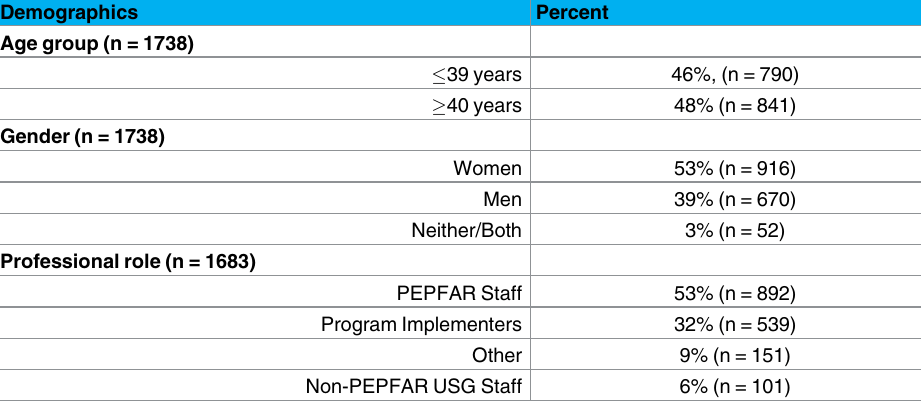
Table 2. Demographics of training